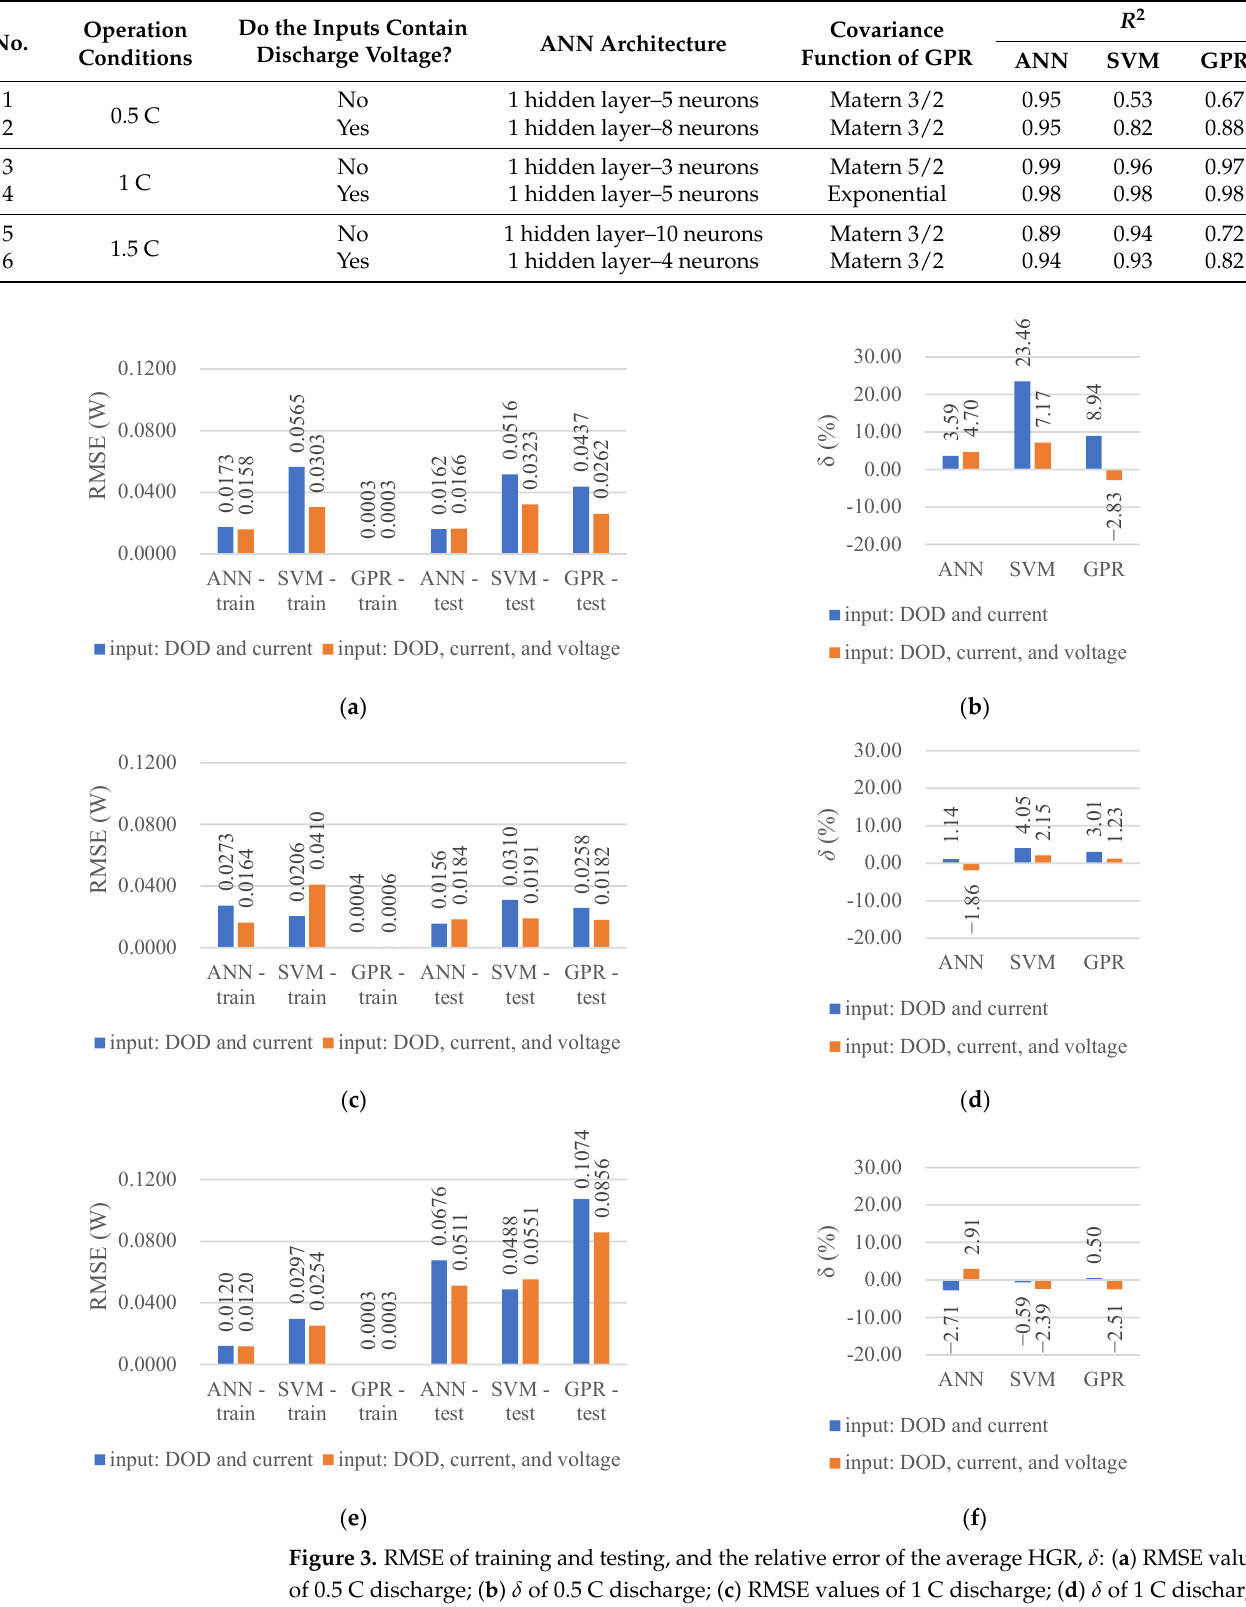
Figure 2. Comparison of the estimated and actual HGRs: ( a ) 0.5 C discharge without discharge volt- age as an input; ( b ) 0.5 C discharge with discharge voltage as an input; ( c ) 1 C discharge without discharge voltage as an input; ( d ) 1 C discharge with discharge voltage as an input; ( e ) 1.5 C dis- charge without discharge voltage as an input; ( f ) 1.5 C discharge with discharge voltage as an input. Table 2. ANN architectures and covariance functions of GPR that were used, and R 2 of the regressions.